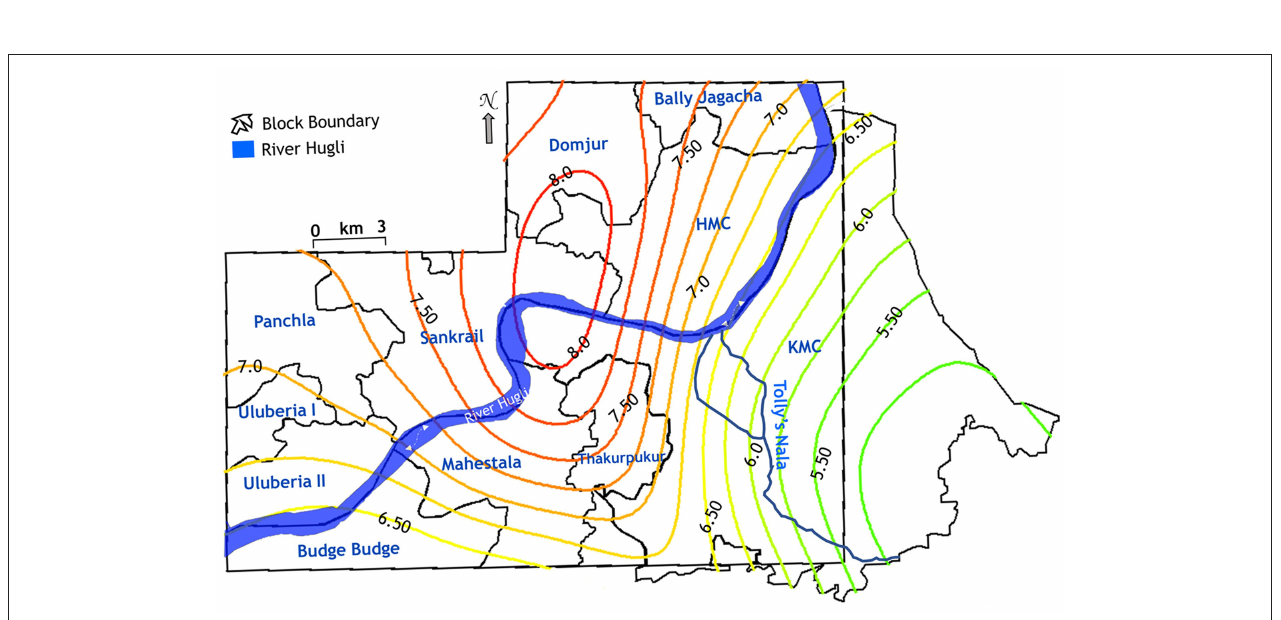
FIGURE 7 | Spatial distribution of head (depth: 100–120m) of the study area under predevelopment conditions.